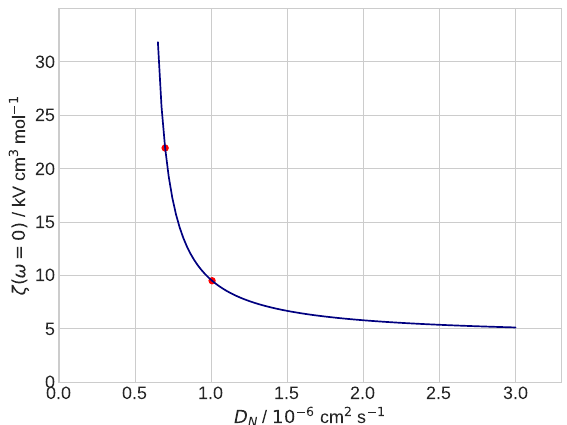
Figure 4. The dependence of static concentration impedance ζ 0 on the oxygen diffusion coefficient in the Nafion film D N . The spectra in Figure 2 are plotted at the points indicated by red